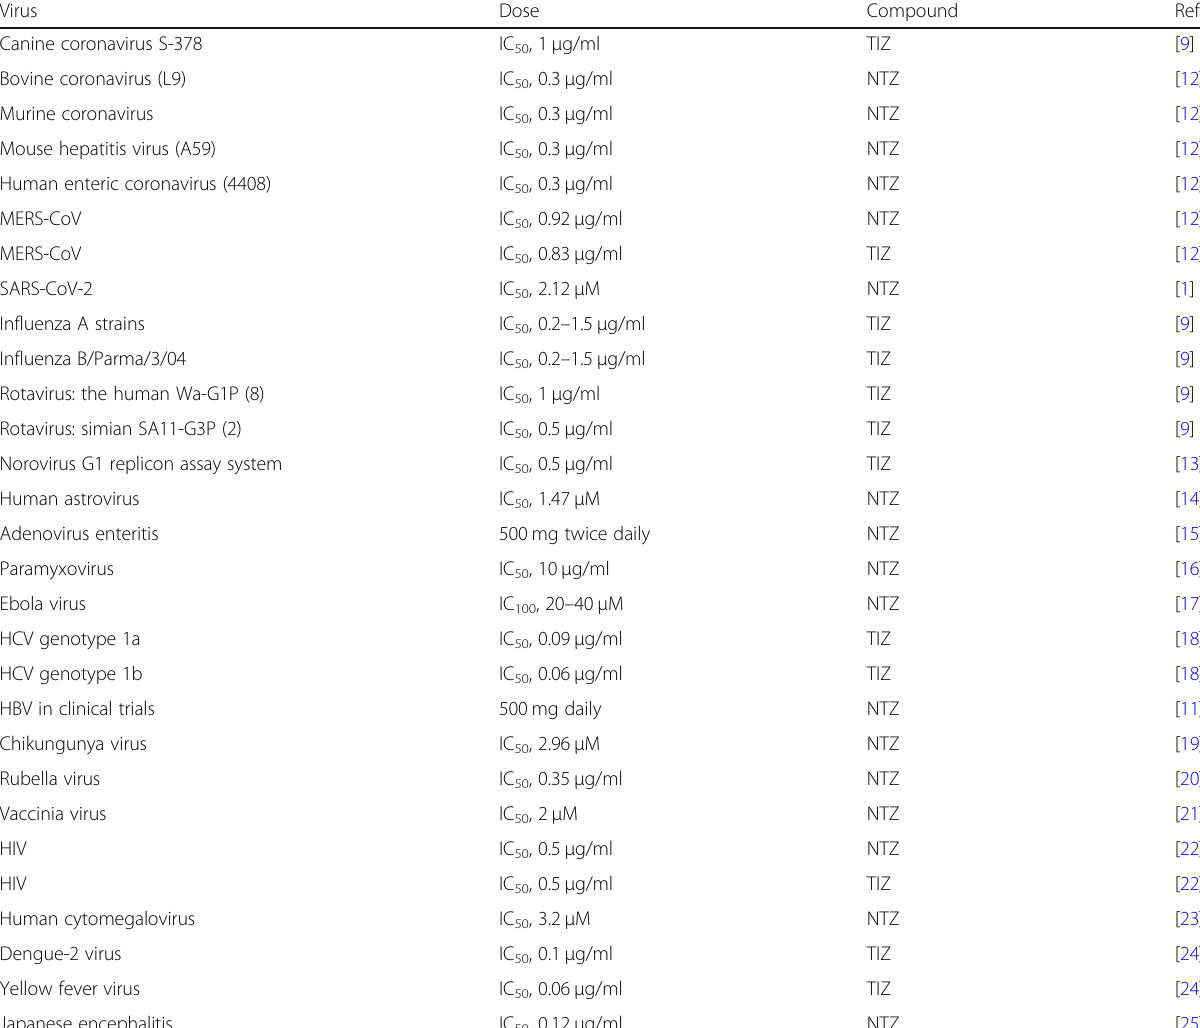
Table 1 The inhibitory effect of NTZ and tizoxanide (TIZ) as broad spectrum